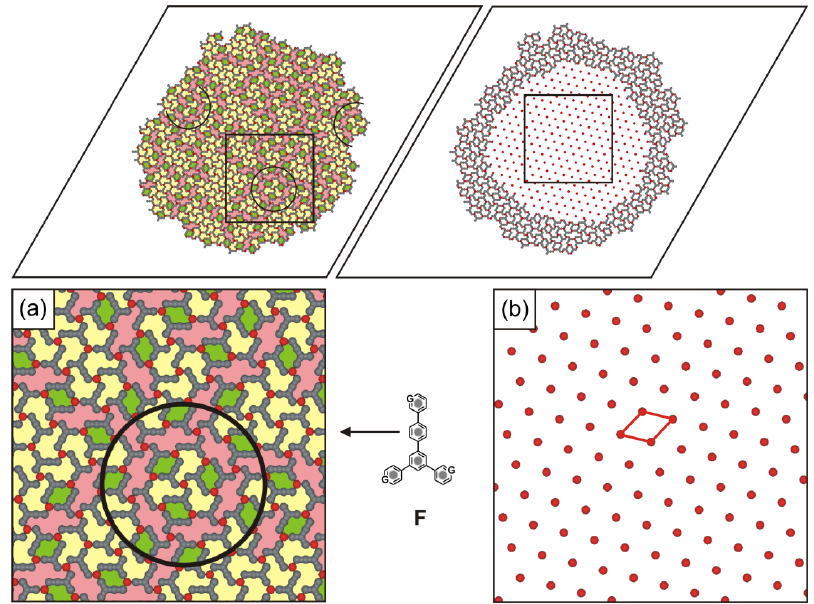
Figure 6. ( a ) The random distribution of nanopores within the metal–organic network built of 600 metal atoms and 600 ligands F . Nanopores differing in size and shape are marked in different col- ors (pink, chalk, and light-green). The solid black oval in the magnified fragment of the mosaic superstructure encompasses a hexagonal closed rosette with a periodic arrangement of metal at- oms and linkers F . The incomplete solid black ovals denote the positions of open-walled rosettes; ( b ) supramolecular phase from Figure 5a, where some bridging ligands F were removed to better visualize a highly periodic distribution of metal atoms (red isolated segments). The solid red line indicates a primitive rhombic unit cell ( √13 × √13 ∠ 60/120 (cid:2925) ). Even after the cursory visual inspection of the aperiodic mosaics illustrated in Figure 5a,b, it becomes clear that the metal-directed self-assembly of molecules F could produce and metal atoms. Small fragments of such artificially created connections are shown in Figure 7. Especially interesting among them are the overlayers composed of flower-like rosettes (Figure 7a,b). The first of them ( (cid:2025) = 0.533 ) is built of adjacent hexagonal rosettes with central windmill-like coordination nodes oriented clockwise (see Figure 7a). The second polymorph, with a huge rhombic unit cell ( √234 × √234 ∠ 60/120 (cid:2925) ), also com- prises closed hexagonal rosettes, but some of their central windmill-like nodes are ori- ented anticlockwise (Figure 7b). Moreover, one could imagine a morphologically similar phase (with equal density (cid:2025) ), where the windmill-like coordination nodes are randomly oriented. The third artificial overlayer, shown in Figure 7c, resembles an open porous network obtained for molecule C (see Figure 3b). However, within this phase, the gear-like cavities (1.1.2) (cid:2874) with a diameter (cid:1856) = 6 (corner-to-corner), are surrounded concentrically by smaller pores comprising four and six adsorption sites. The last crys- talline pattern is homogenous in terms of porosity ( (cid:2025) = 0.533 ) and comprises only irreg- ular voids containing seven adsorption sites each (Figure 7d).